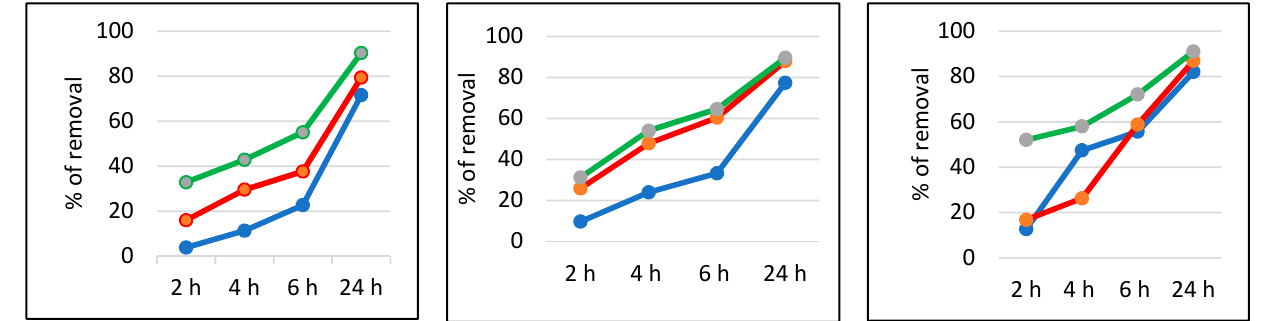
Figure 9. Percentage of removal of MB using 2.5 mg of material ( left ), 5 mg of material ( center ), and 10 mg of material ( right ). Note: hydrogen peroxide contents: 2 mg (blue line), 5 mg (red line), 10 mg (green line).